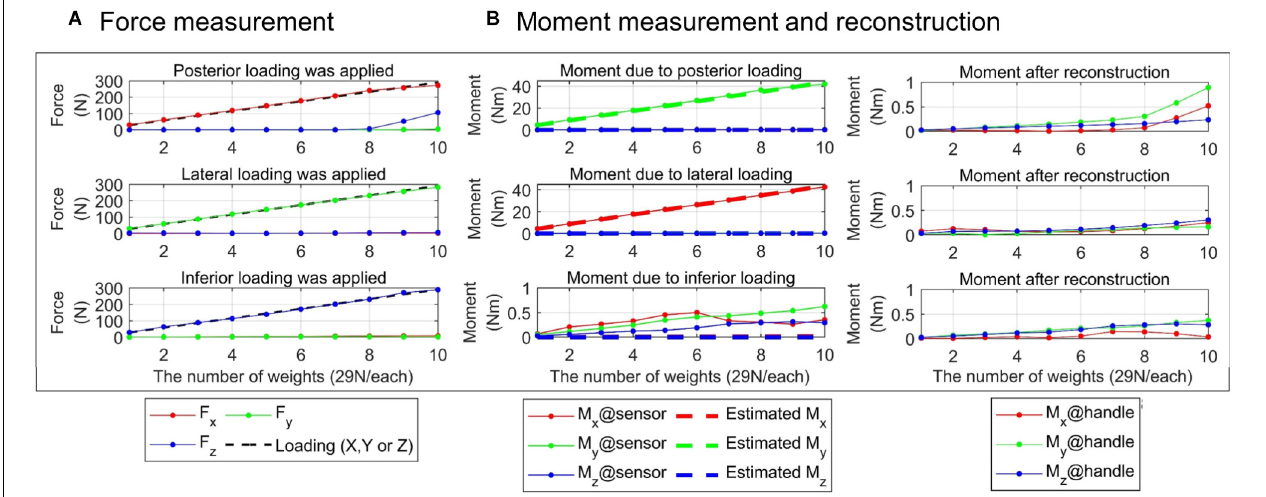
FIGURE 4 | Evaluation of force/moment measurement accuracy. Result at the first posture of the gimbaled handle is presented. Absolute force/moment values in each of three directions are shown. (A) Forces measured by the load cell (left column). The black dotted line represents the actual loading applied on the cell. (B) Moment measured by the load cell (middle column, solid lines with star marks). The actual moment was estimated as the magnitude of the loading multiplied by the distance between the sensor and the point of the loading (dotted lines). Moment at the handle (right column) was reconstructed using Eq. 1.